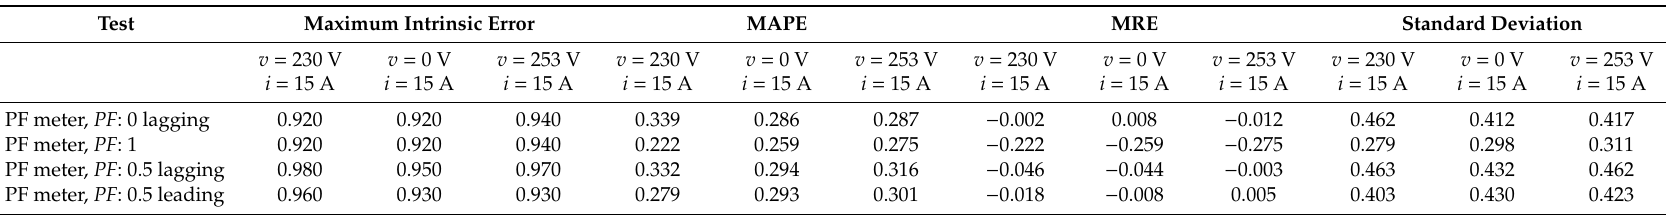
Table 8. Alternating current / voltage component variation test (PF meter, voltage variation): maximum intrinsic error (%), MAPE (%), MRE (%), and standard deviation (%).